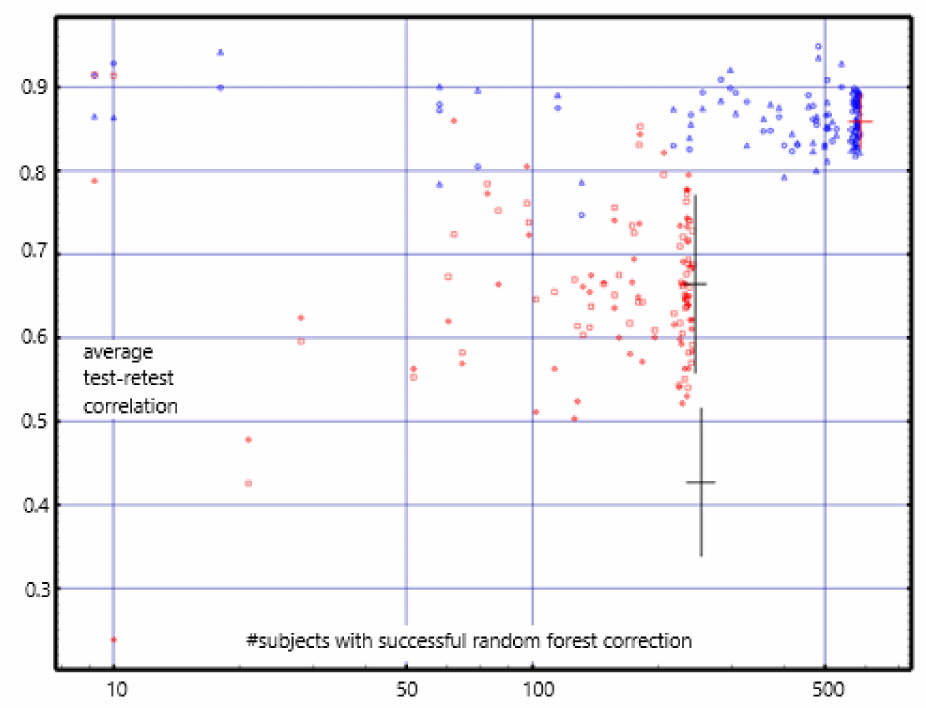
Figure 3. The y-coordinate of each dot is the average test-retest correlation for a region of interest. The x-coordinate is the number of subjects for whom the random forest empty-room adjustment was successfully applied for that ROI. Short-term test-retest reliability is shown in blue, i.e., resting vs. task in the same sitting. Long-term ( mean 16 months) reliability is shown in red. The error bars show the mean ± 1.0 standard deviation for the short-term values (red bar), long-term (upper black bar), and for the less accurate empty-room correction used in previous work (lower black bar) [10]. The improvement in test-retest reliability with application of the random forest empty-room correction is significant with p < 10 − 26 , t = 13.953, df = 126.3 (Welch’s t-statistic). Only the 68 cortical ROI measures were used for the error bar and t-statistic calculations since these are the ROIs to which both random forest and the previous empty-room correction were